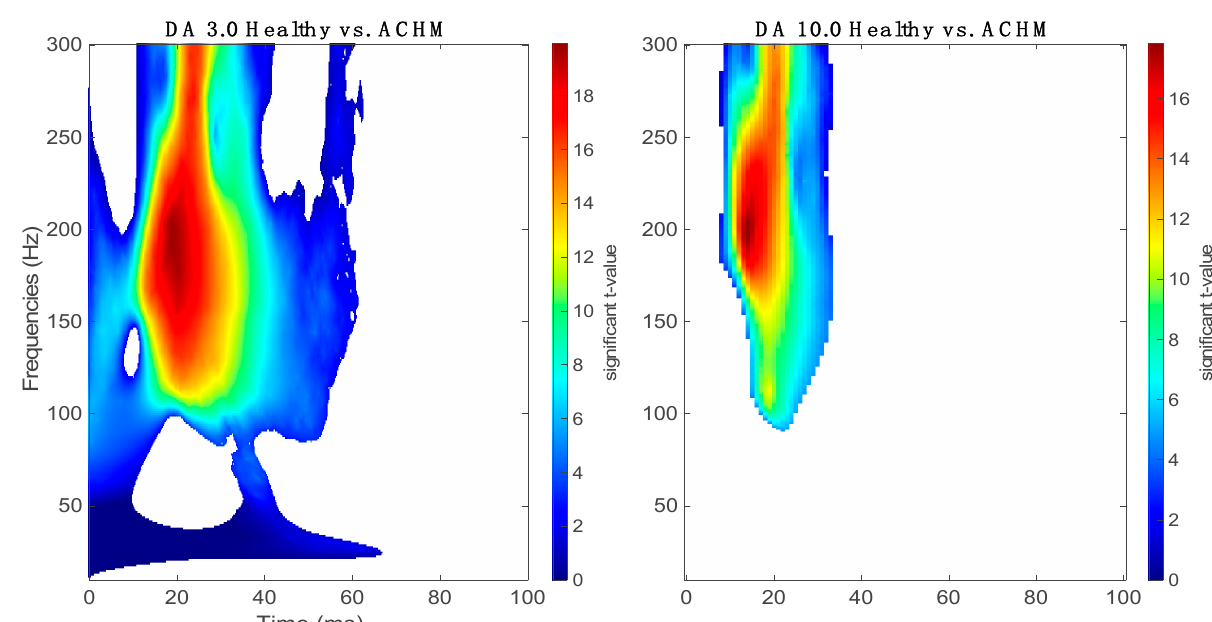
Figure 3. Statistical cluster-based permutation analysis: on the left, the comparison between normal and achromat groups shows a significant cluster ( p < 0.05, one-tail) spread within 50 ms mainly at high frequencies at a luminance level of DA 3.0; on the right, the comparison between the healthy and the achromat groups shows a significant cluster ( p < 0.05, one-tail) mainly focused on the second cluster of frequencies corresponding to the OPs at a luminance level of DA 10.0.